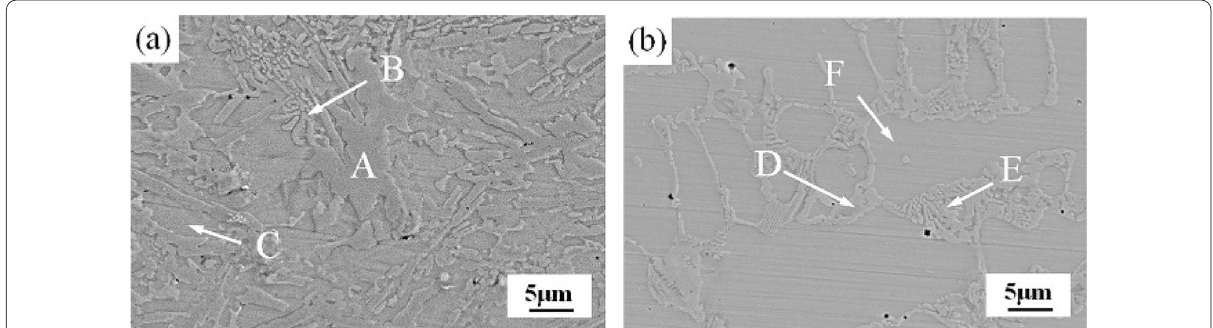
Table 5 EDS composition analysis of Nickel-based composite coating